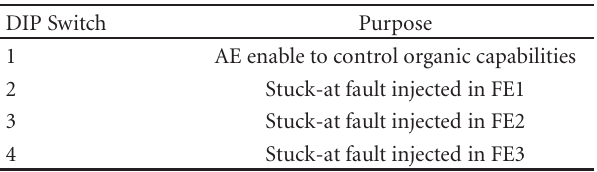
Table 4: DIP switch purposes.